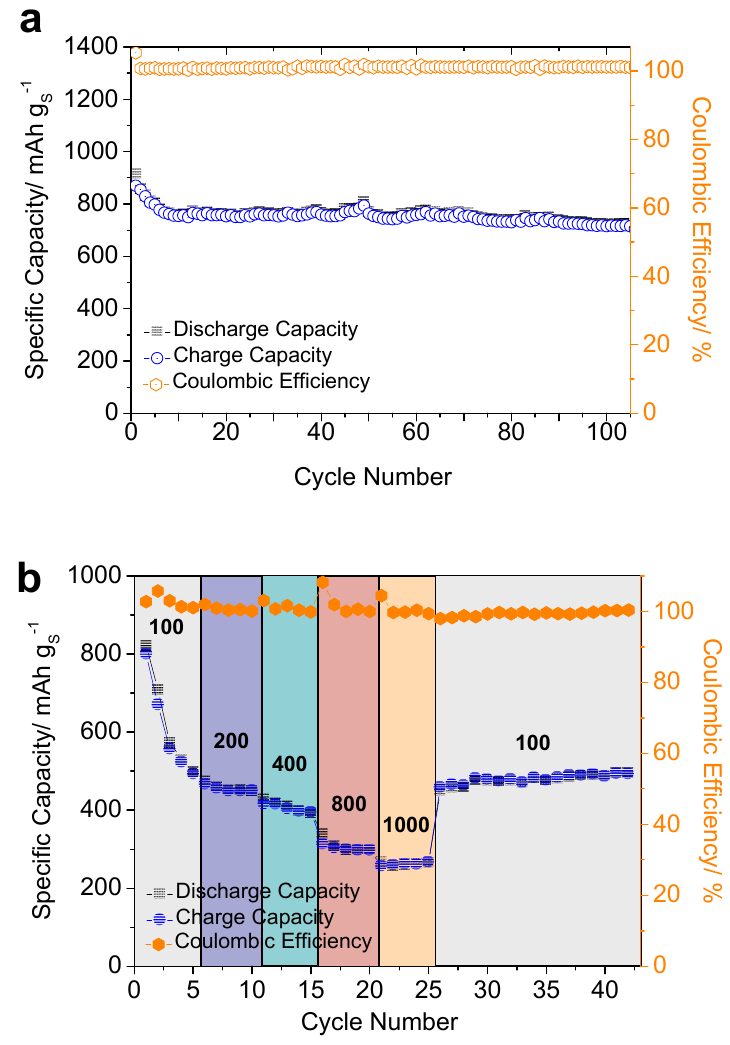
Figure 7. ( a ) Cycling performance of the ASC/S composite at a current of 100 mA g − 1 and ( b ) rate capability test at various current densities.